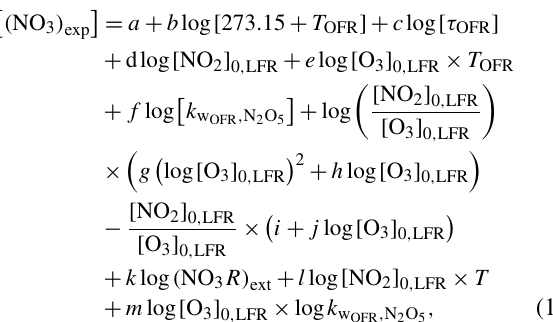
Table 1. Study-average values of MAC from Arizona and Oregon. Errors are 1 standard